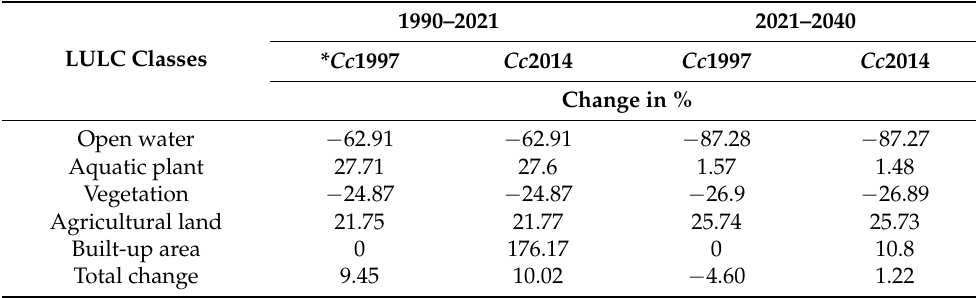
Table 8. The change rate of ESV during the observed period (1990–2021) and predicted period